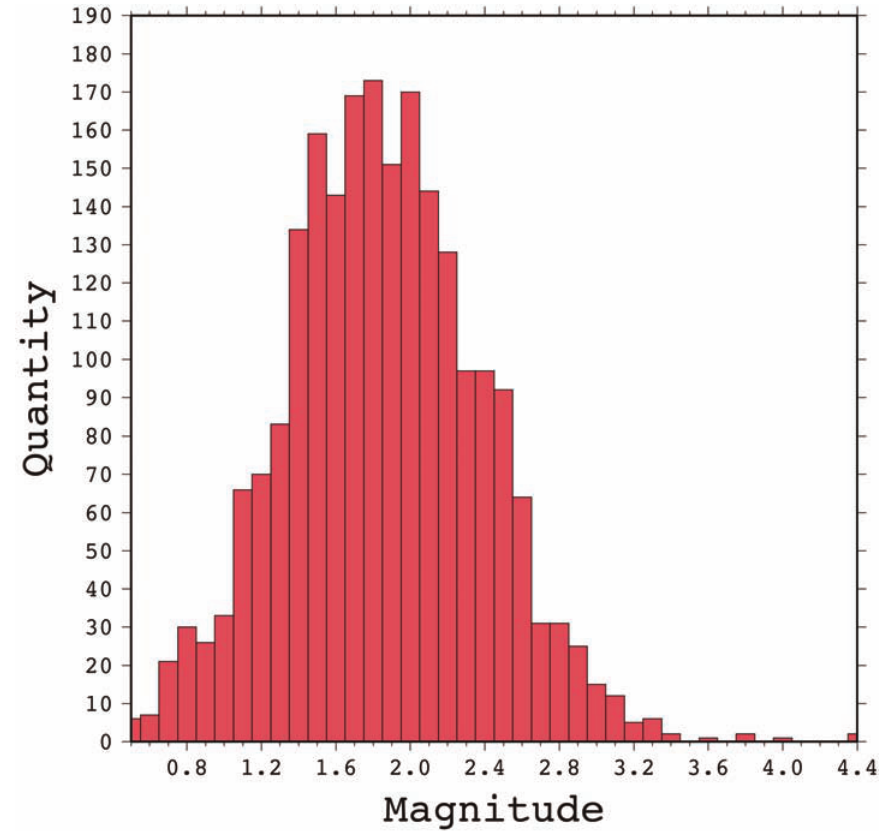
Figure 8. Histogram for the Armutlu Peninsula dataset.